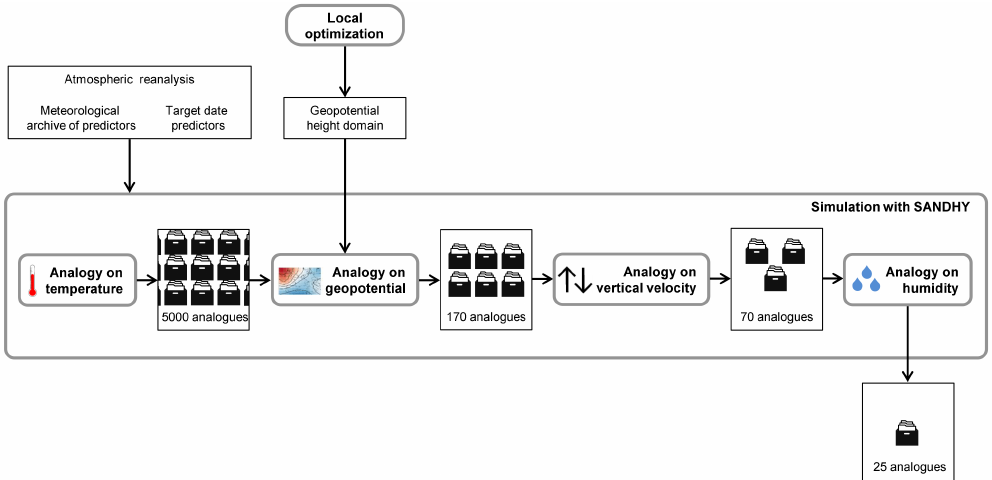
Figure A1. Synthetic diagram showing the sequence of analogy steps in the SANDHY method to reconstruct precipitation and temperature over a climatically homogeneous zone for a specific target date.